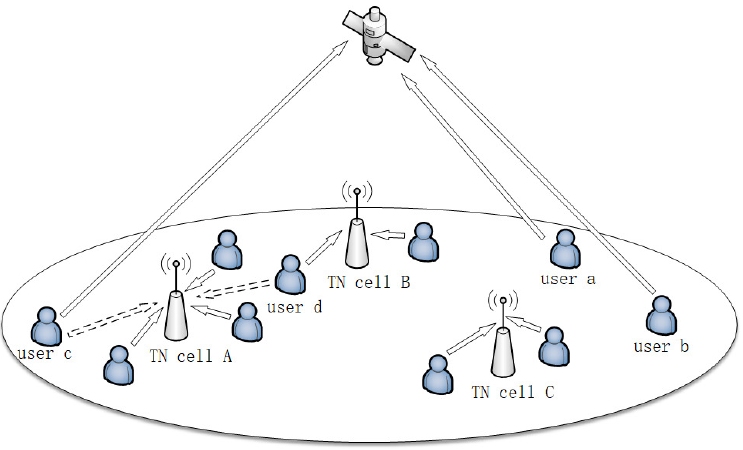
Figure 1. Diagram of load balancing in a satellite–terrestrial integrated